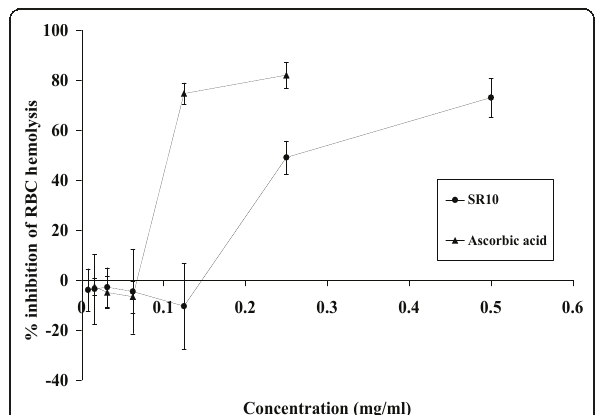
Figure 1 Effect of SR10 on AAPH-induced hemolysis in erythrocytes . Erythrocyte suspension was incubated with PBS (set as 0% inhibition), various concentrations of ascorbic acid (positive control) or SR10 in the presence of 100 mM AAPH for 200 minutes at 37°C. Values are expressed as mean ± S.D. of three independent experiments.